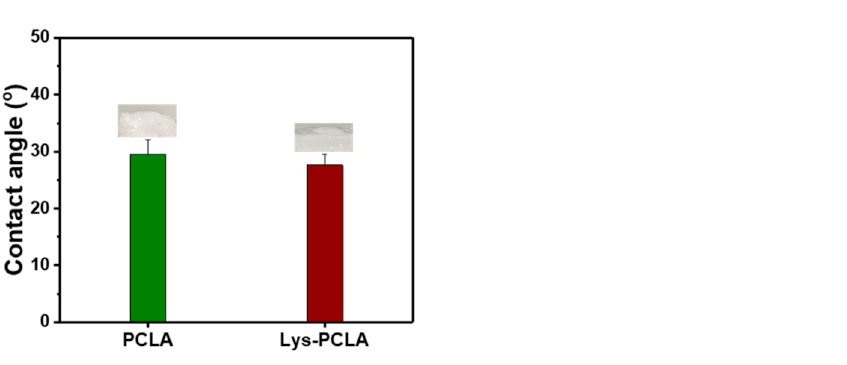
Figure 4. Water contact angle of PCLA and Lys-PCLA hydrogels. Data are presented as mean ± SD ( n = 4).